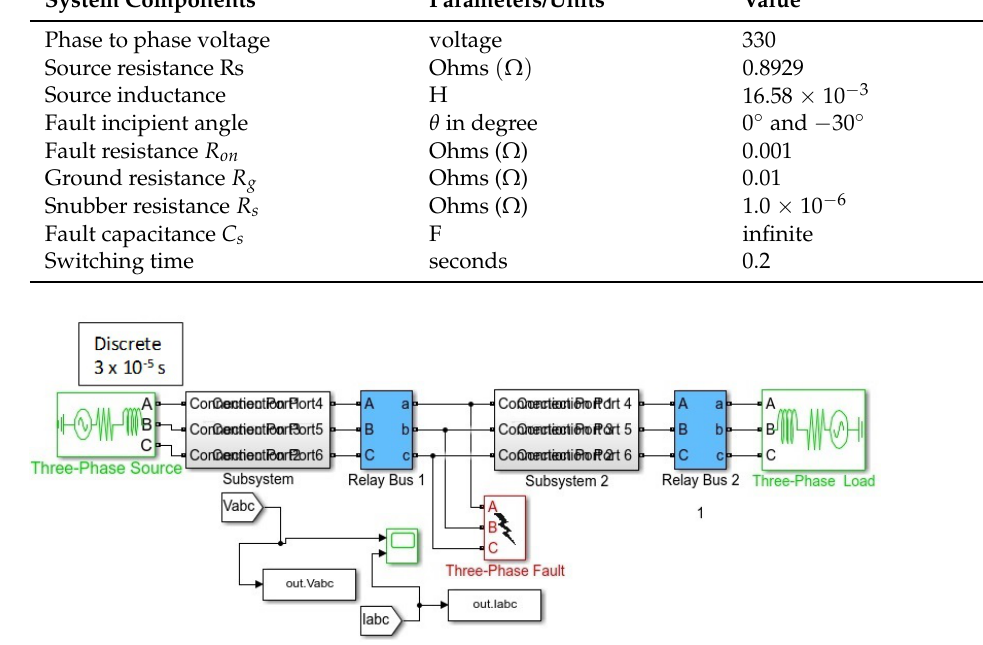
Figure 2. Simulink Model of 330 kV. 500 km transmission